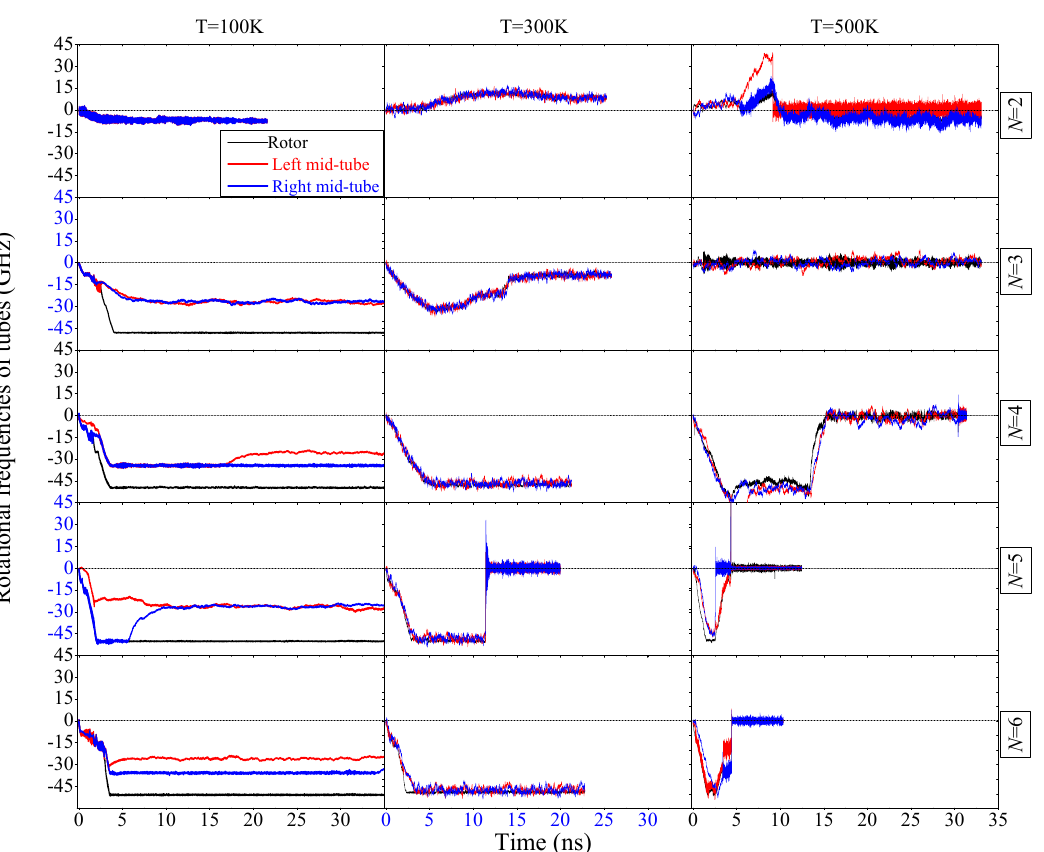
Figure 3. Snapshots of the system under different conditions. ( a ) Bonding process among the components in system with N = 5 at 300 K. ( b ) Sudden collapse of DNs with N =4 at 500 K. ( c ) Sudden collapse of mid tubes in the system with N = 5 at 500 K.